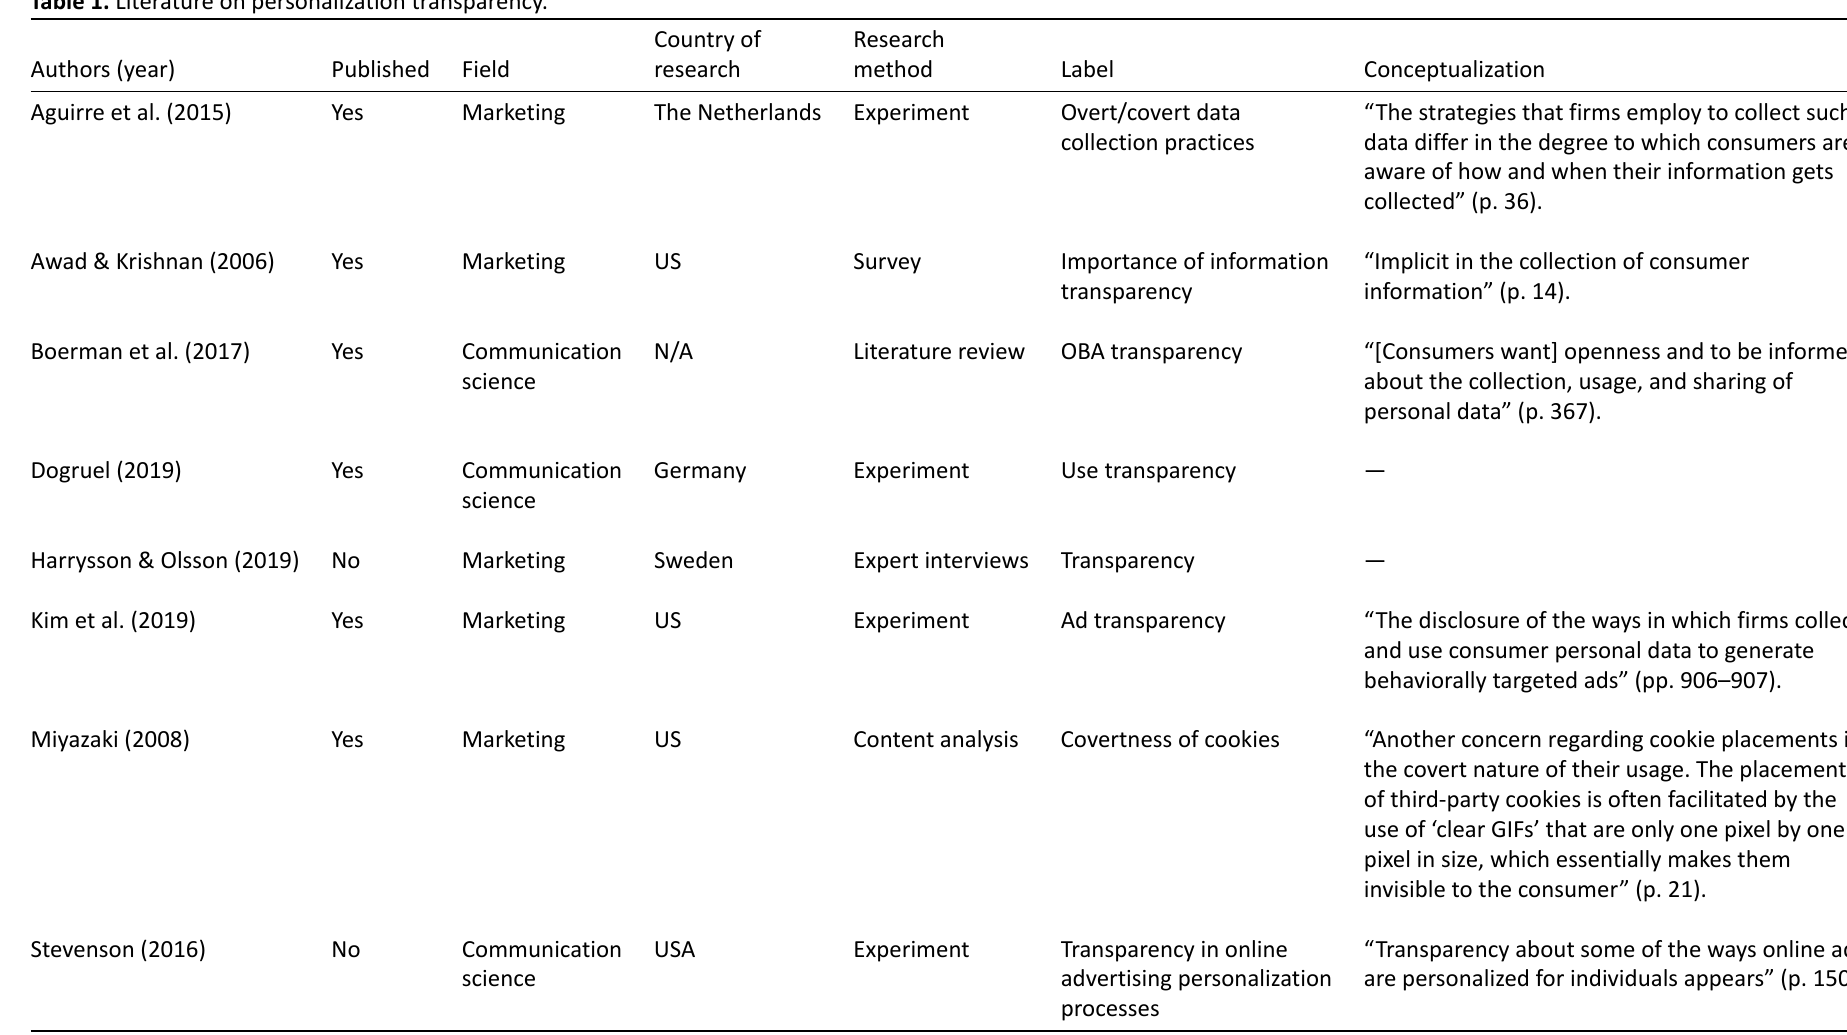
Table 1. Literature on personalization